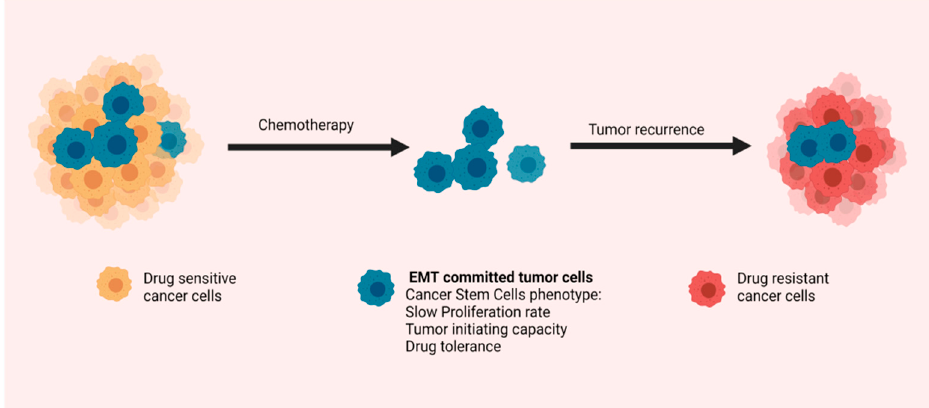
Figure 3. EMT and chemoresistance: Tumor cells undergoing EMT acquire a number of features associated with a cancer stem cell phenotype, which make them intrinsically tolerant to chemotherapy. They are therefore capable of surviving drug exposure and form a new tumor, leading to disease recurrence.